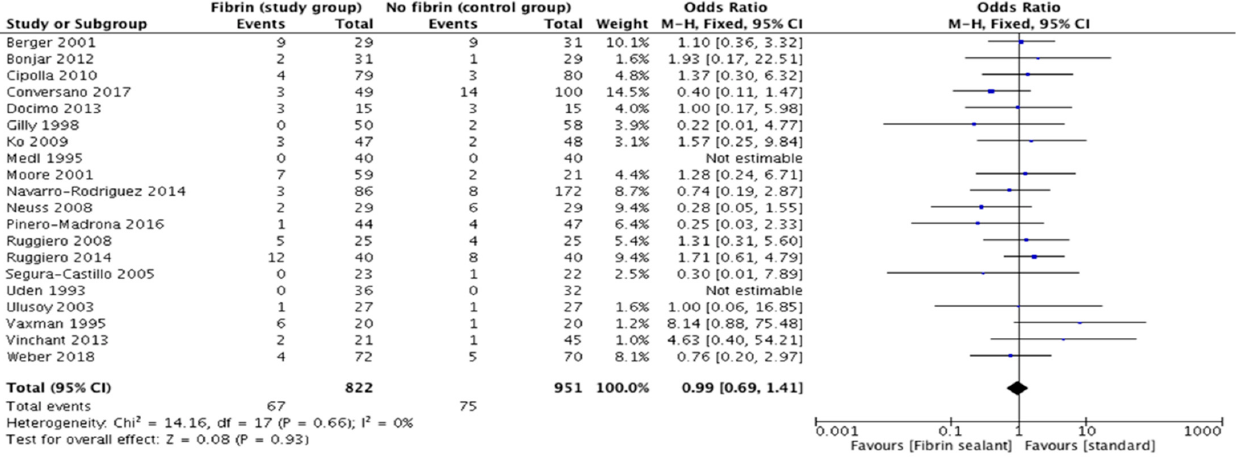
Figure 5. Surgical site complications.